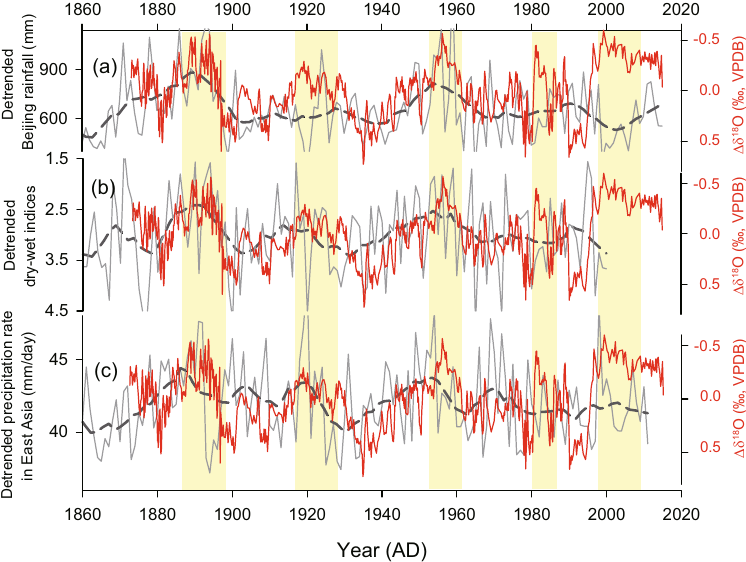
Figure 5. Comparison between the detrended Shihua δ 18 O record (red) and detrended precipitation dataset from different regions (gray curves). ( a ) Annual rainfall in Beijing 46 . ( b ) Dry-wet indices (DWI) in North China (37.5–42.5°N/112.5–117.5°E) 59 . ( c ) Annual precipitation rate in East Asia (20–45°N/110–140°E) 60 . The thin lines and bold dashed lines indicate annual and 7-year running mean curves, respectively. The yellow bars highlight the periods of lighter δ 18 O